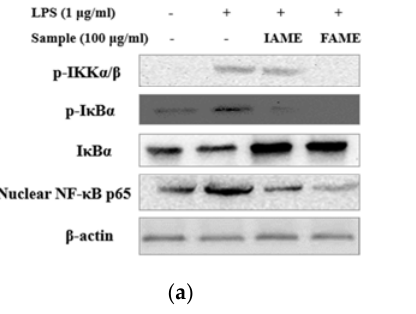
Figure 8. Effects of IAME and FAME on lipopolysaccharide (LPS)-stimulated NF- κ B signaling pathway. Raw264.7 cells were pretreated with IAME and FAME (100 µ g/mL) for 2 h and then stimulated with LPS (1 µ g/mL) for 20 h. Equal amounts of cell lysates (30 µ g) were subjected to electrophoresis and analyzed for p-IKK α / β , p-I κ B α , I κ B α , and NF- κ B p65 expression by performing Western blotting. Actin was used as an internal control. ( a ) p-IKK α / β , p-I κ B α , I κ B α , and NF- κ B p65 protein expression. ( b ) Expression levels of p-I κ B α , I κ B α , and NF- κ B p65. Each value is expressed as the mean ± SD ( n = 3). a–d Values with different letters are different at p < 0.05, as analyzed by Duncan’s multiple range test. IAME, Abelmoschus manihot extract; A. manihot extract fermented by Bacillus licheniformis CP6.